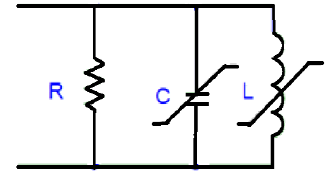
Fig 2. equivalent circuit model for the graphene where R represent the loss and L or C represent the resonance nature of graphene and are caused by imaginary part of its